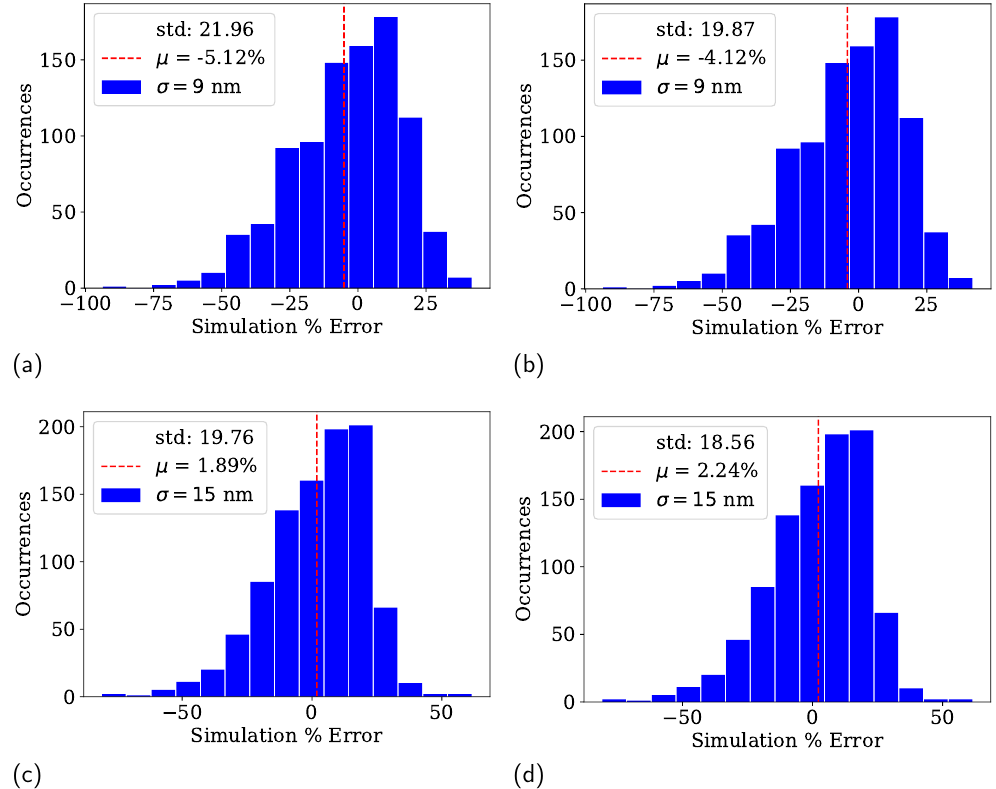
Figure 7. Percent error in propagation loss α (dB/cm) between analytical (14) vs. FDTD solutions: ( a ) 924 roughness profiles at σ = 9 nm, ( b ) same as ( a ) with data filtering, ( c ) 947 roughness profiles at σ = 15 nm, and ( d ) same as ( c ) with data